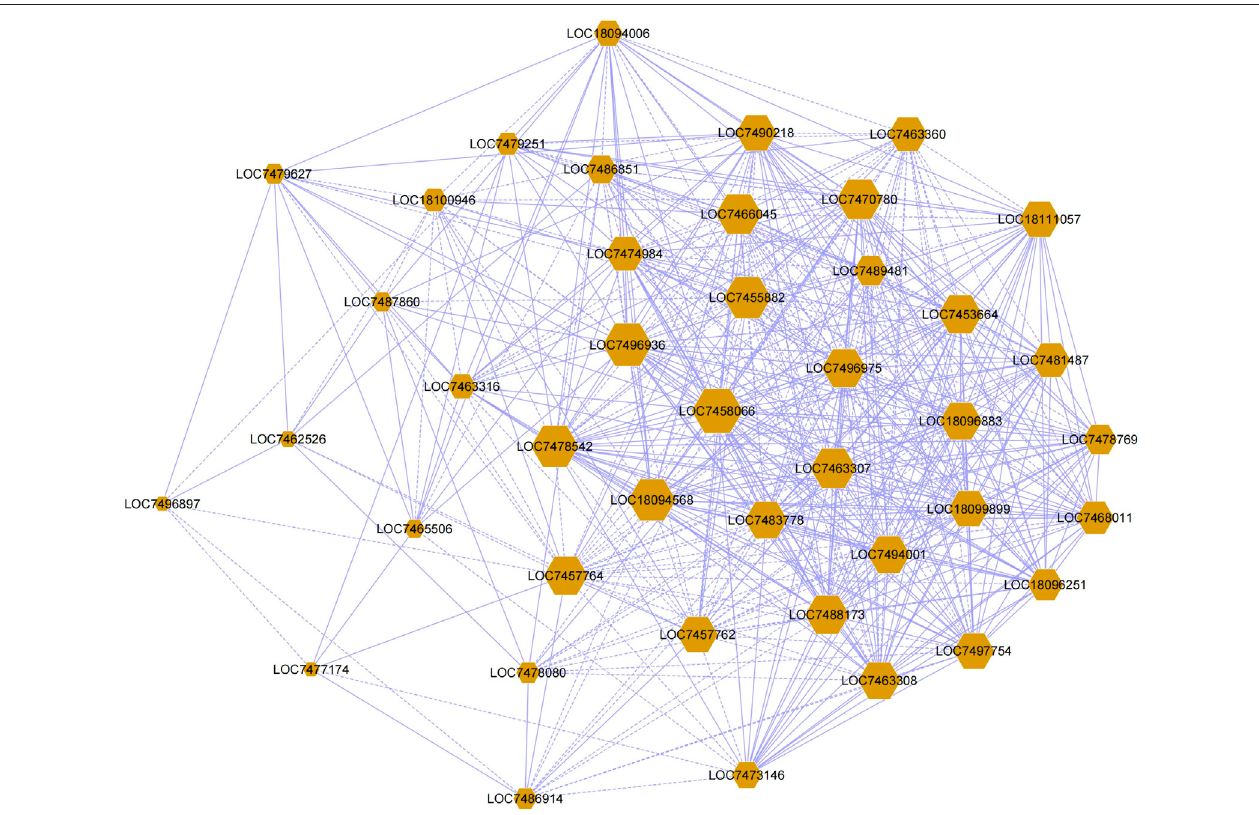
FIGURE 12 | Co-expression-based gene networks of PtrMFS gene family. Dots represent genes. Lines indicate that they have co-expression relationships.